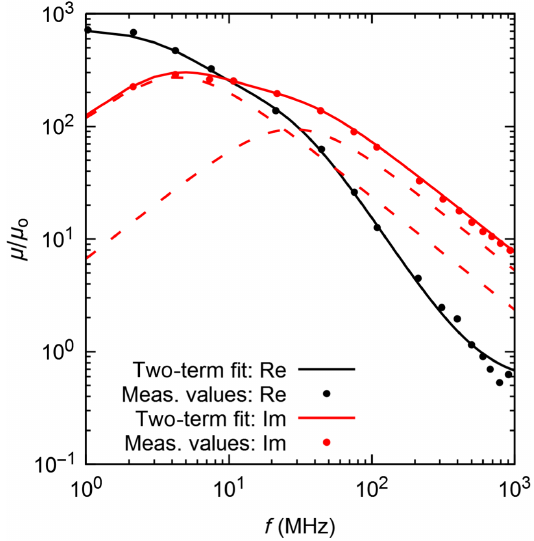
FIG. 8. Reflection (black) and transmission (red) coefficients FIG. 7. Experimental data and two-term Lorentzian fit for for an incident transverse wave striking a ferrite slab at normal permeability of PE11BL ferrite. The imaginary parts of the incidence. The ferrite is modeled using a two-term Lorentzian fit two separate Lorentzians are shown as red dashed lines. Param- to permeability data for PE11BL. The slab has a width of eters used for the fit are C 1 ¼ 7 . 90 , f o 1 ¼ 0 . 67 GHz, and 1.885 cm. Solid lines show theoretical results using the fitted δ ¼ 50 GHz, C ¼ 8 . 98 , f ¼ 0 . 26 GHz, and δ ¼ 50 GHz frequency-dependent permeability. Dots show the simulation 1 2 o 2 2 for the second. Adapted from Ref. [12]